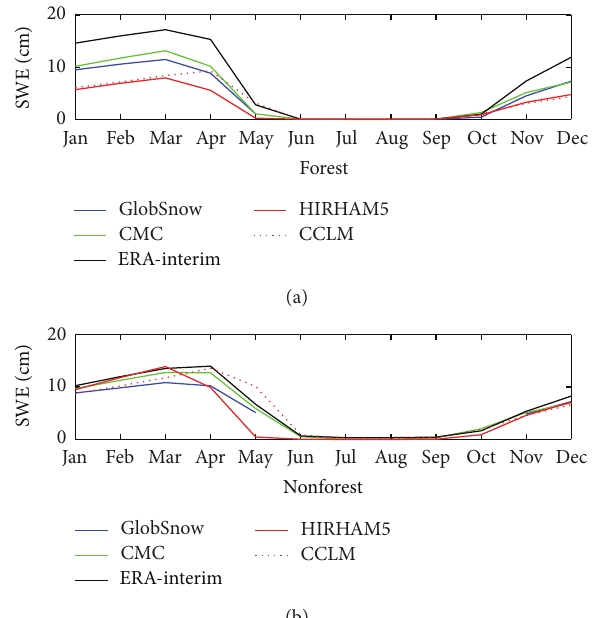
Figure8:Annualcycleofsnowwaterequivalent(SWE;cm)forSiberiansubdomainderivedfromHIRHAM5,CMC,ERA-interim,GlobSnow and CCLM averaged over 2008 to 2010 for forest (a) and nonforest (b) areas.